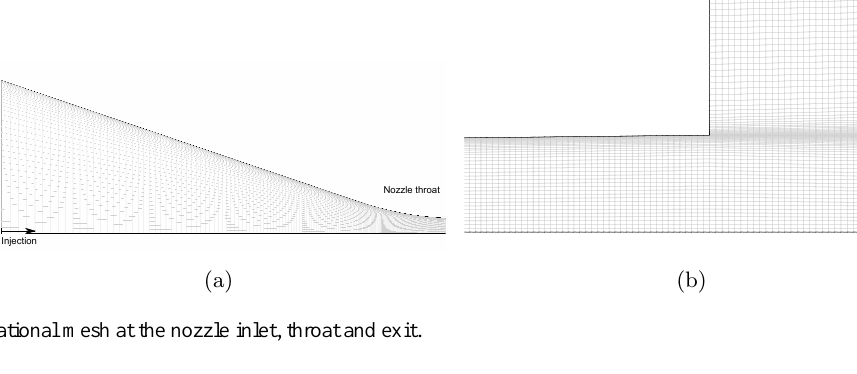
Figure 3. Computational mesh at the nozzle inlet, throat and exit.